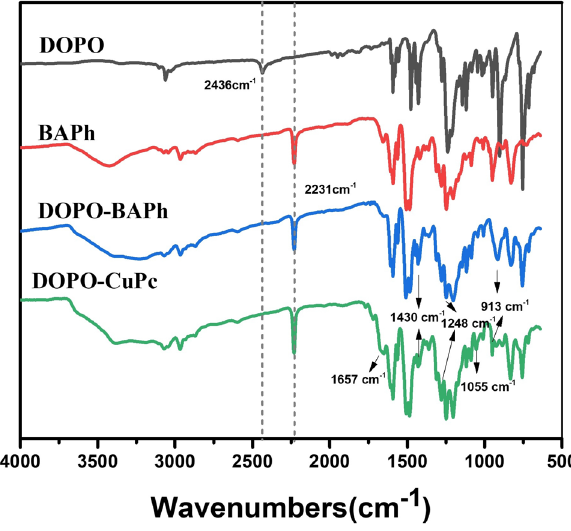
Figure 1. FTIR spectrum of DOPO, BAPh, DOPO-BAPh and DOPO-CuPc.